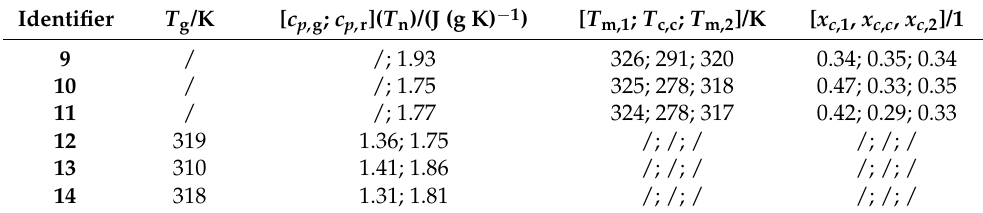
Table 2. Structural characteristics obtained using DSC: glass transition points Tg, heat capacities in the glassy and rubbery states at Tn = 298.15 K, temperatures of melting and crystallization during the first heating, cooling and second heating Tm,1, Tc,c, Tm,2, and the corresponding amounts of crystalline phase x c,1 , x c,c , x c,2 calculated from the respective ∆ Hf.